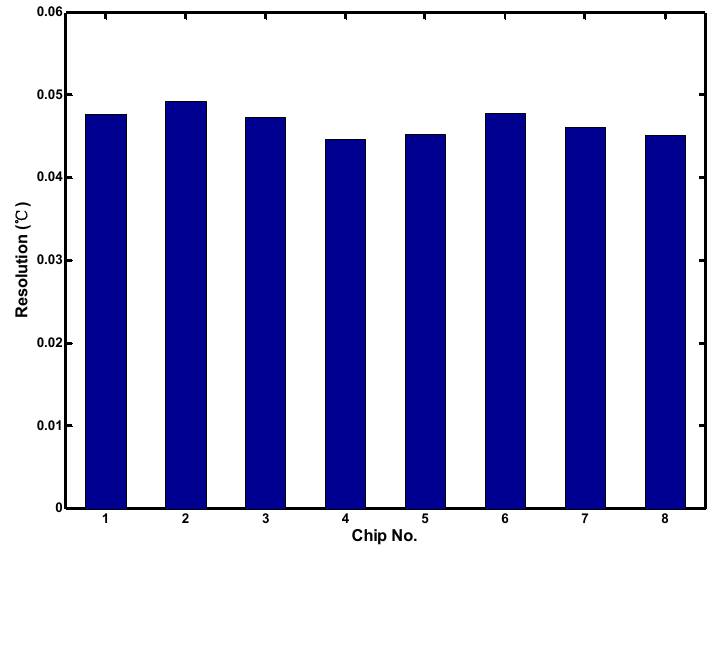
Figure 15. Effective resolution variation for eight